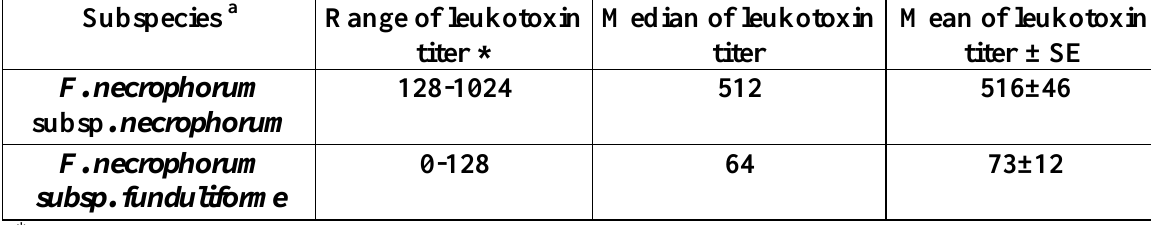
Table 2: Means of leukotoxin titers in culture supernatants of F. necrophorum subspecies necrophorum and F. necrophorum subspecies funduliforme